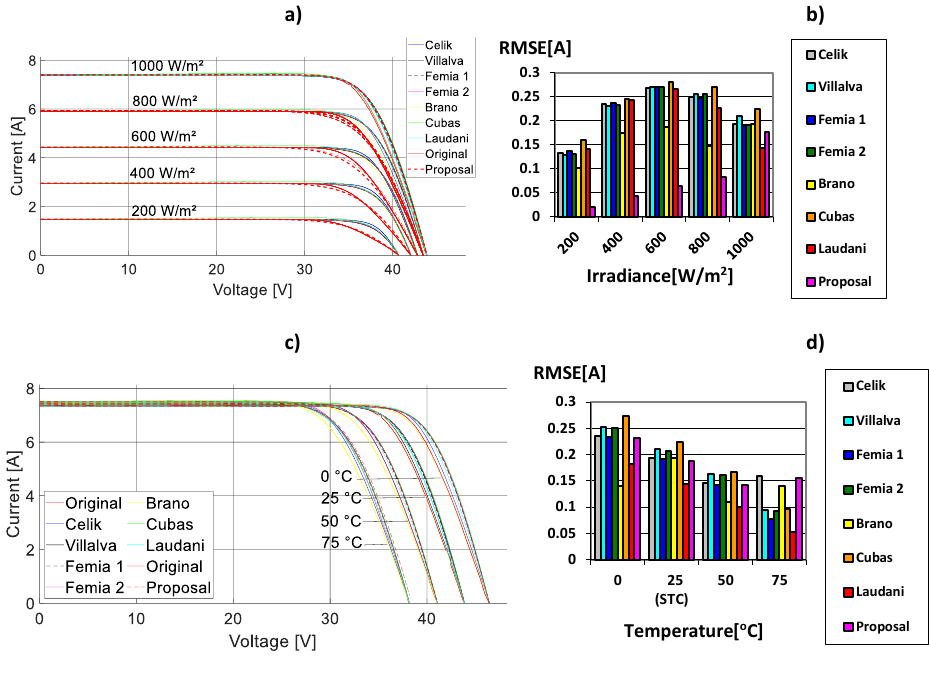
Figure 6. Comparison between calculated (eight models) and issued I-V curves of Sanyo HIT-240HDE4: ( a ) at T = 25 ◦ C; ( b ) RMSE at T = 25 ◦ C; ( c ) at G = 1000 [W/m 2 ]; ( d ) RMSE at G = 1000 [W/m 2